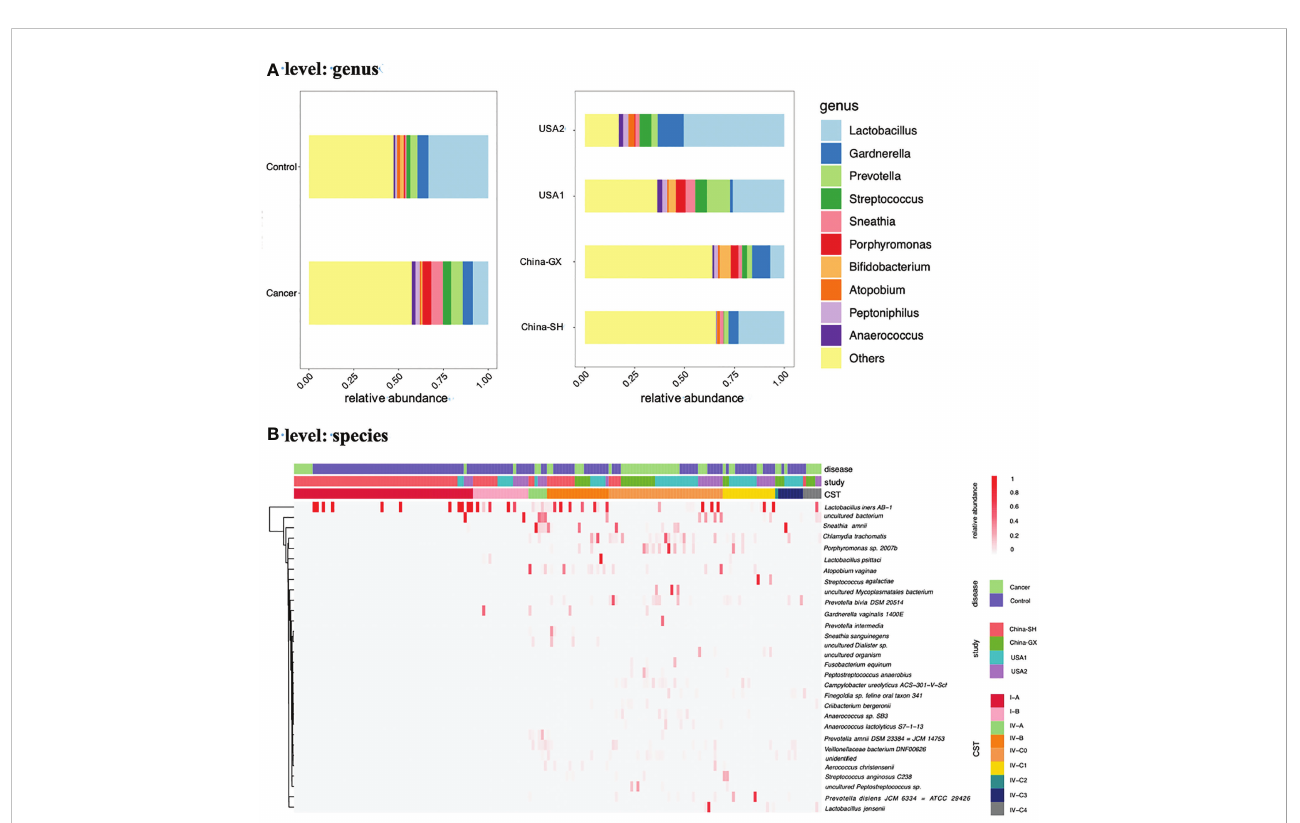
FIGURE 1 The relative abundance of the top 10 genera and 30 species across all samples. (A) Bar chart showed the relative abundances of the top 10 genera according to the disease and study. (B) Heatmap showed the relative abundances of the top 30 species across 4 studies. The proportions of samples assigned to each CST across all samples were also presented (B) .